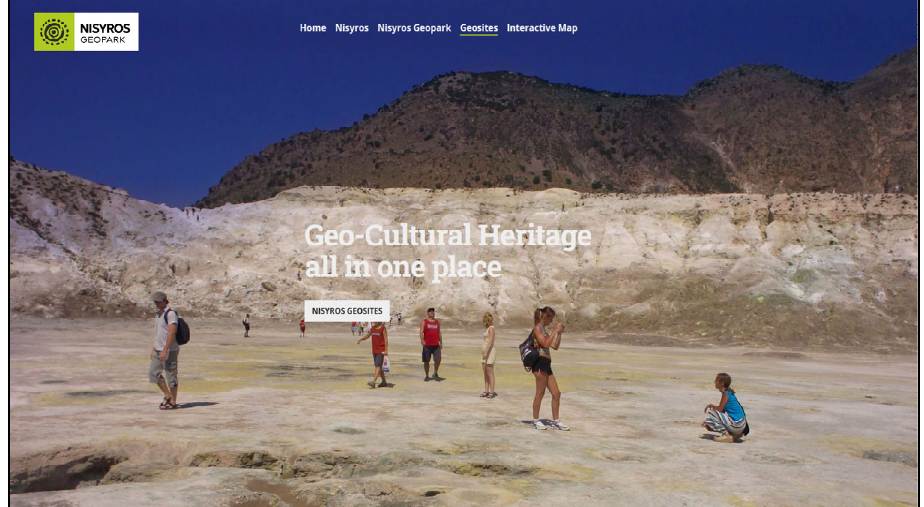
Figure 9. Example of a starting page of one of the sections of the Nisyros Geopark website (Geosites). Specific attention was given to the presentation of high ‐ quality, full screen imagery of different the ‐ matic areas of the Geopark.